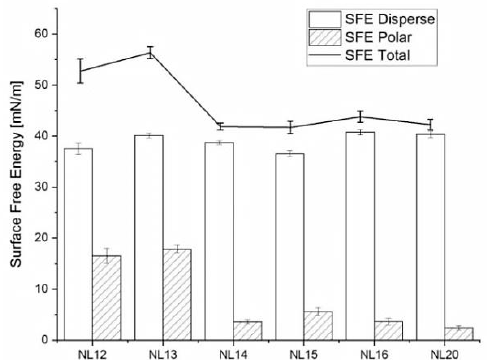
Figure 11. Surface free energy values: total, dispersive part (white boxes), and polar part (striped boxes); mean ± S.E.M., n = 10.